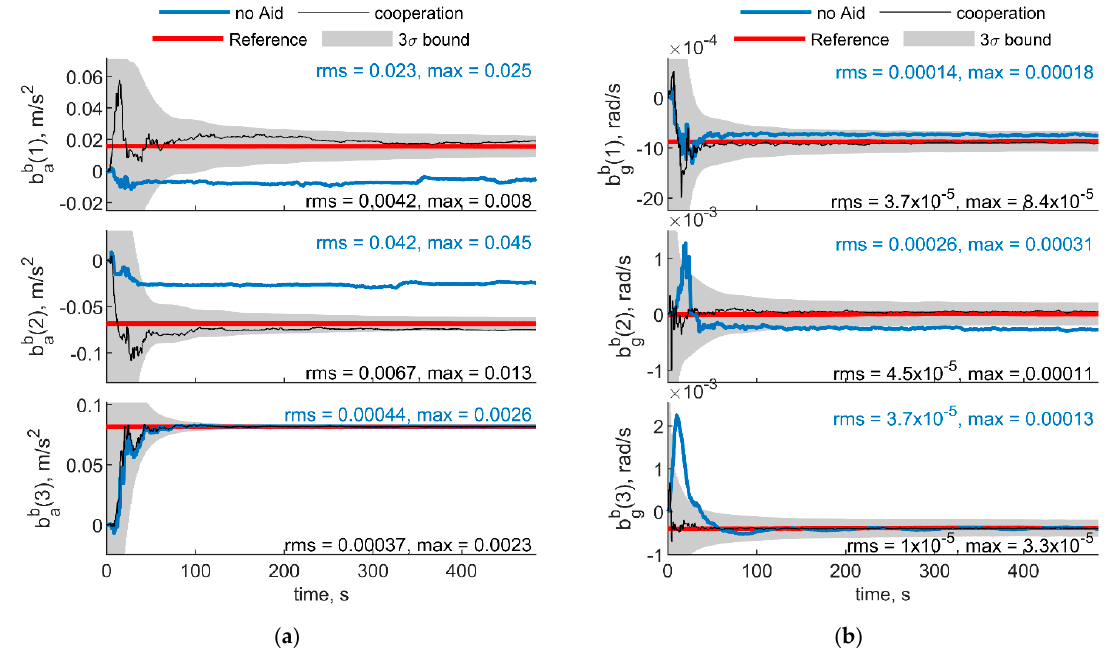
Figure 17. ( a ) Accelerometer and ( b ) gyroscope biases predicted by the filter. One deputy. Chief and deputy formation identified by case 2. Reference value is reported in red. Results obtained with cooperation and without cooperation have been reported in black and blue, respectively. RMS and maximum error value have been evaluated starting from t = 60 s.